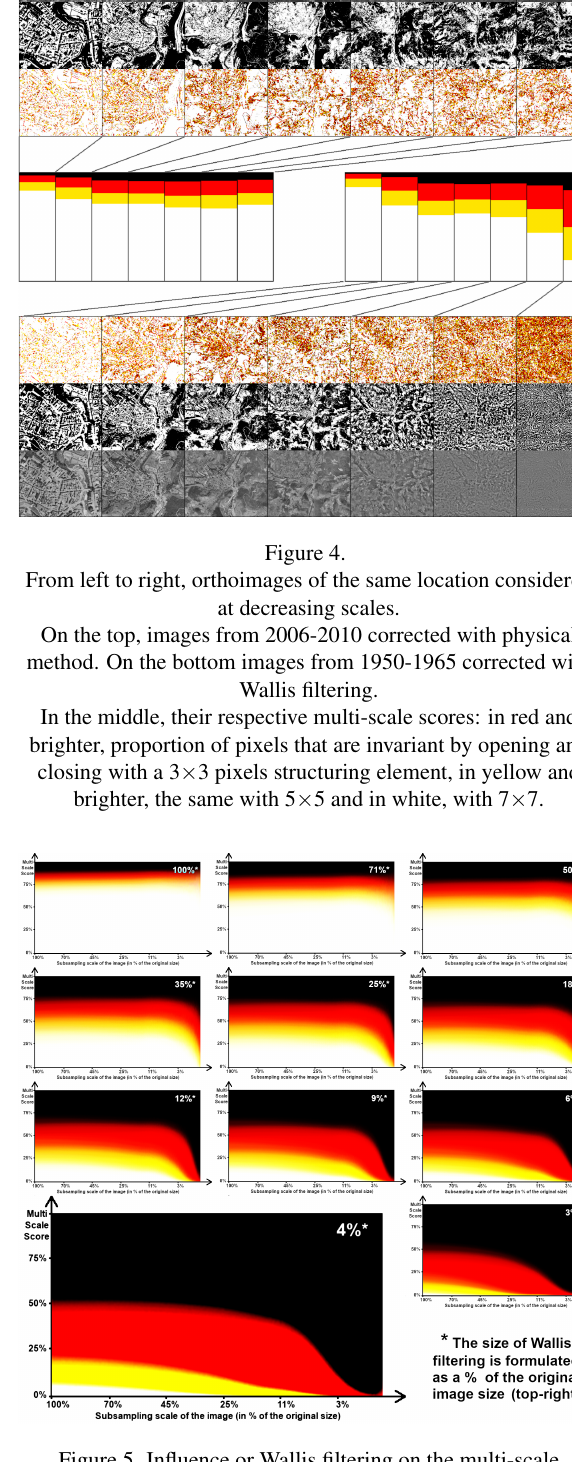
Figure 5. Influence or Wallis filtering on the multi-scale scores of the 143 images